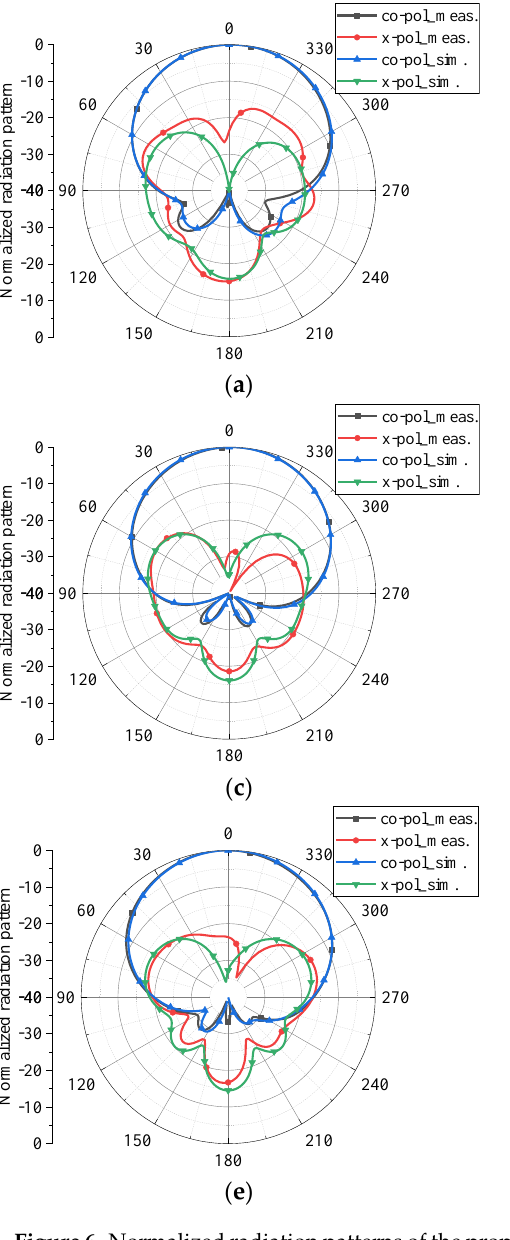
Table 3. Half power beam widths (HPBWs) of the proposed antenna.